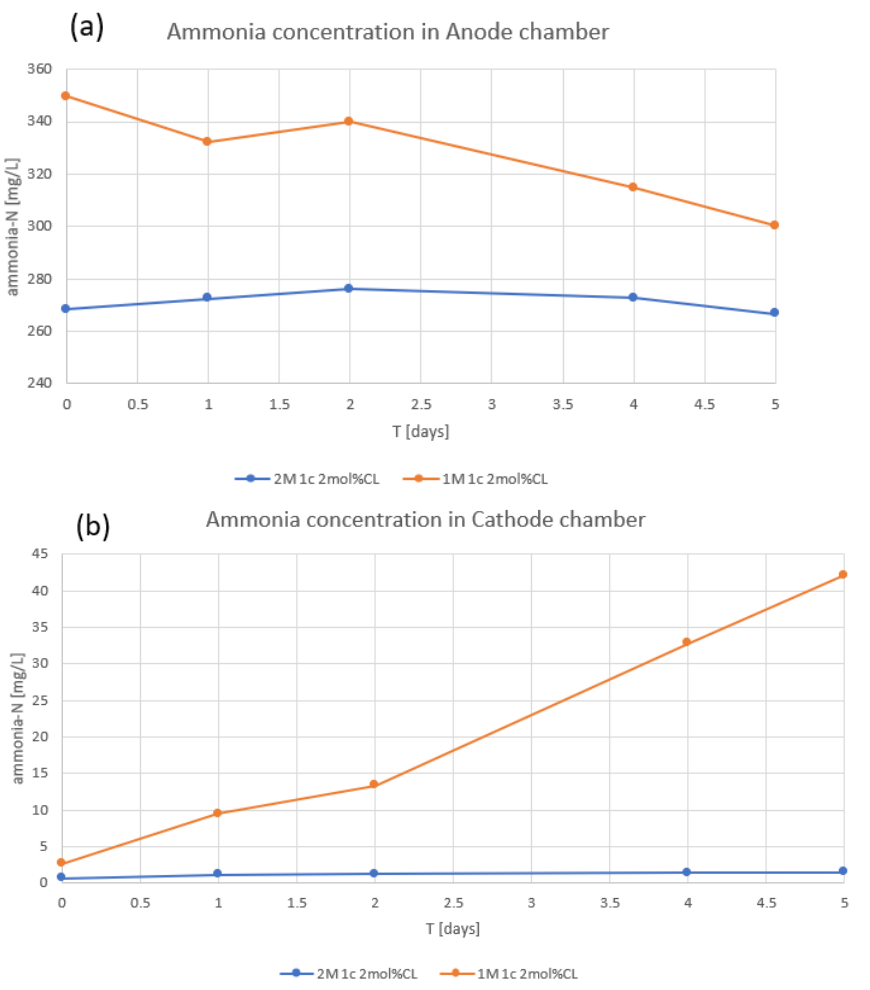
Figure 7. Ammonia flux from the anode to cathode chamber in the batch experiment using 1c 2 mol%CL AEM (orange) and the improved 2 M 1c 2 mol%CL AEM (blue). ( a ) ammonia concentration in the anode chamber. ( b ) ammonia concentration in the cathode chamber. Table 3. Permselectivity measurements using 0.1 M and 0.5 M KCl solutions.